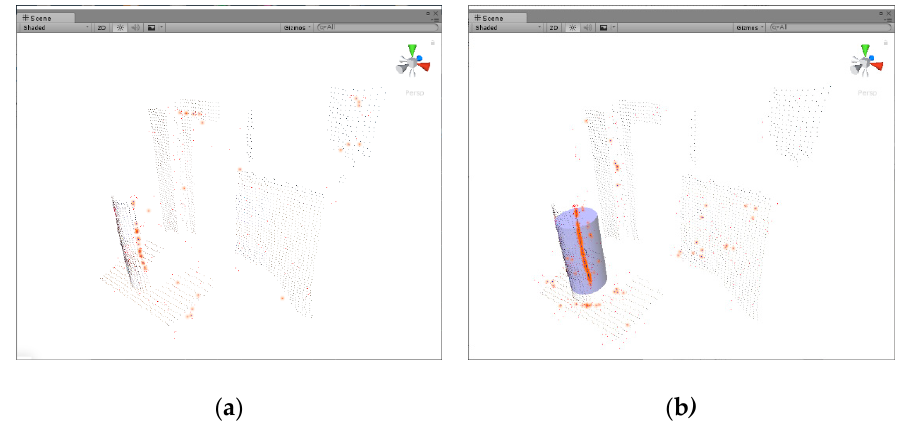
Figure 12. Point data scale k times for estimation 𝛜 = 25: ( a ) the default scale; ( b ) the k times scale.